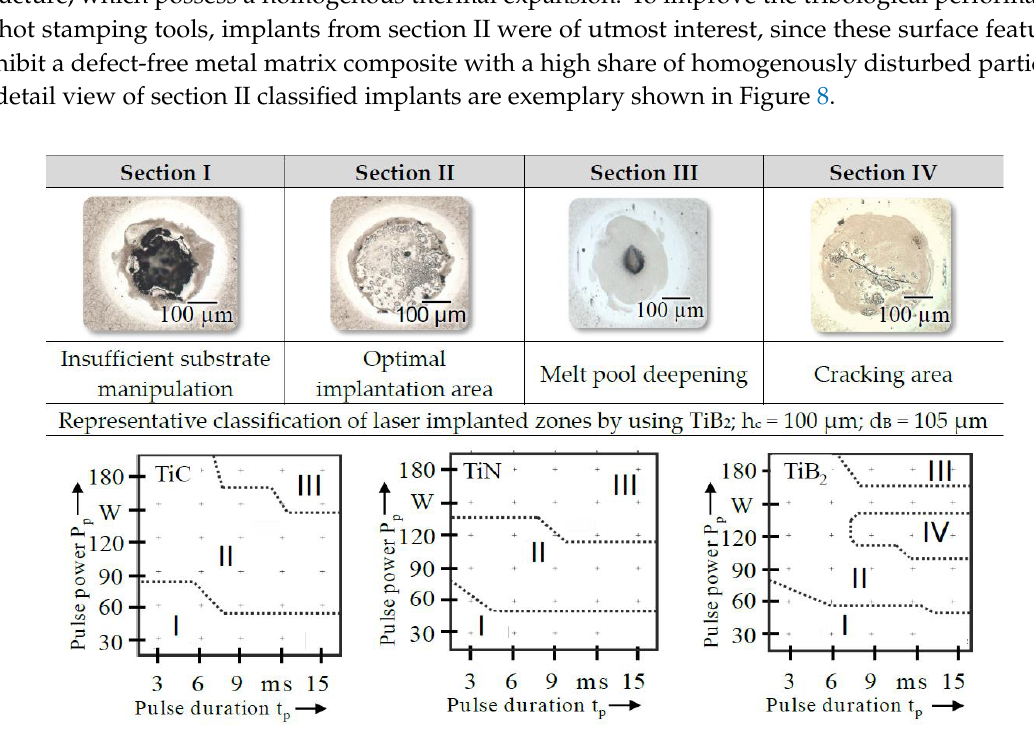
Figure 7. Laser-generated surface features classified according to their visual appearance.